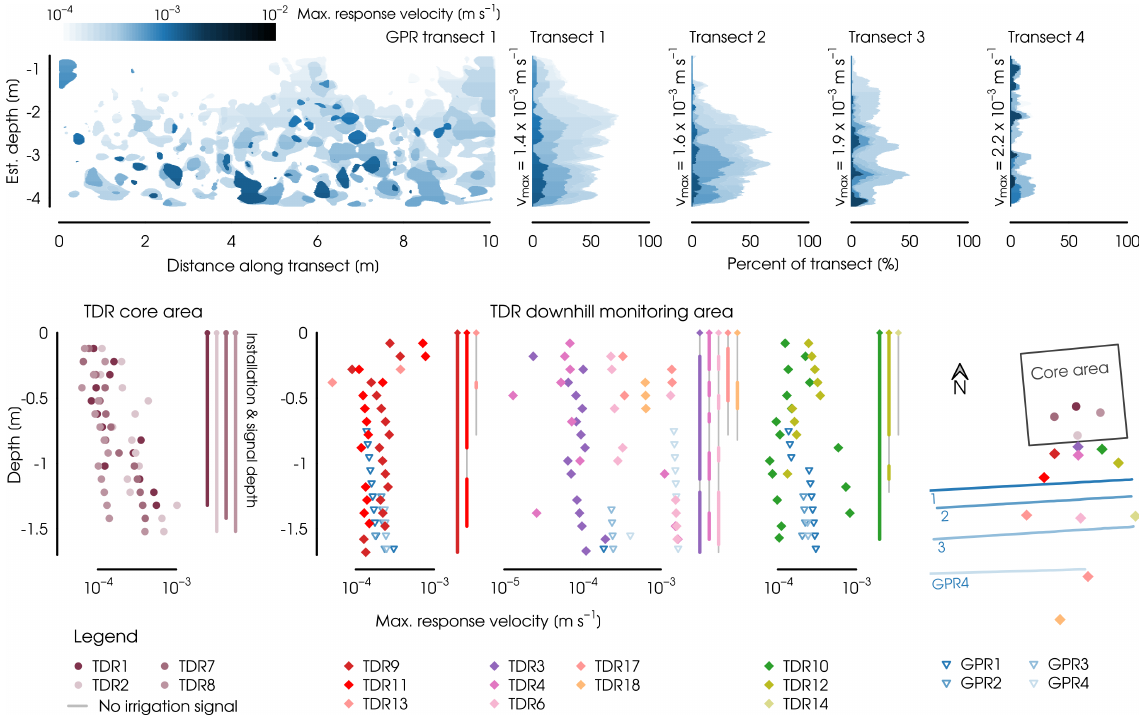
Figure 11. Top: depth distributions of response velocities calculated for the four time-lapse GPR transects. The blue scale indicates the response velocity calculated from the time of first arrival for each pixel. White areas did not show any irrigation water signal. The left plot shows the 2-D results for GPR transect 1. The margin plots on the right show the same data accumulated to 1-D depth profiles for all four GPR transects. Bottom: response velocities calculated from TDR measurements at the core area (strictly vertical), and the downhill monitoring area (vertical and lateral). The three plots showing the TDR profiles at the downhill monitoring area are sorted according to the three diverging transects. Lines within the right margins of each TDR plot show the installation depths of the TDR profiles. Grey sections indicate depth increments that did not show a change in soil moisture. Additionally, GPR-based velocities derived from 0.5m wide sections of the GPR transects close to the TDR profiles are